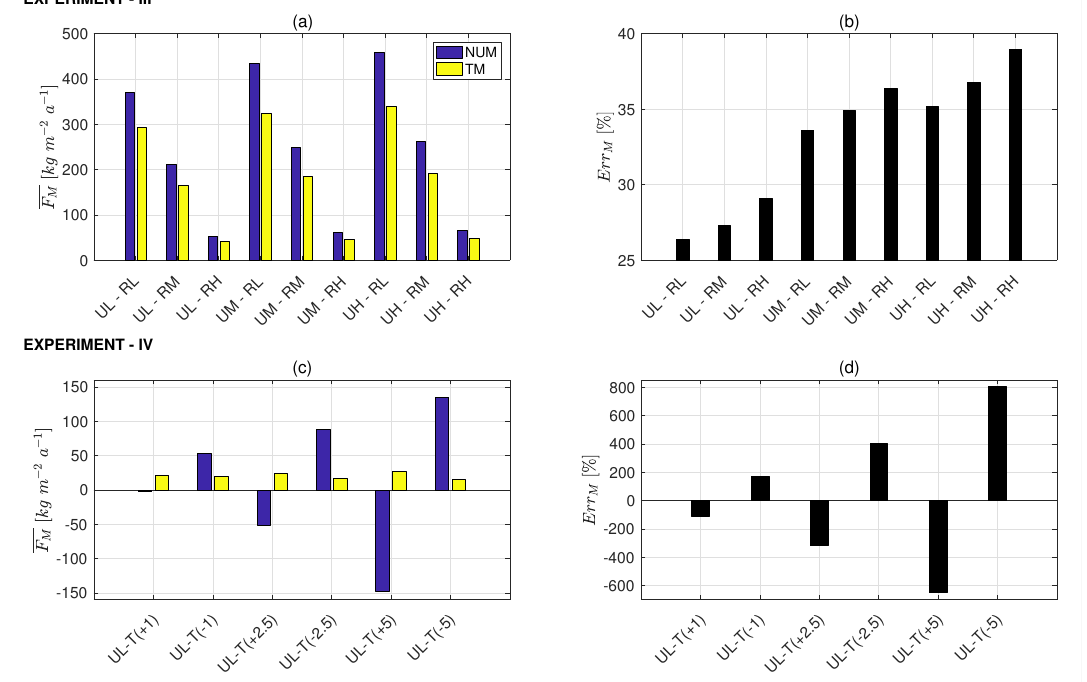
Figure 5. Experiment III: (a) average rate of mass loss during 15min of saltation, (b) error between NUM and TM solutions. Corresponding plots for Experiment IV in (c) and (d) respectively. Note that the units used for rate of mass loss are kilograms per unit area per unit year.